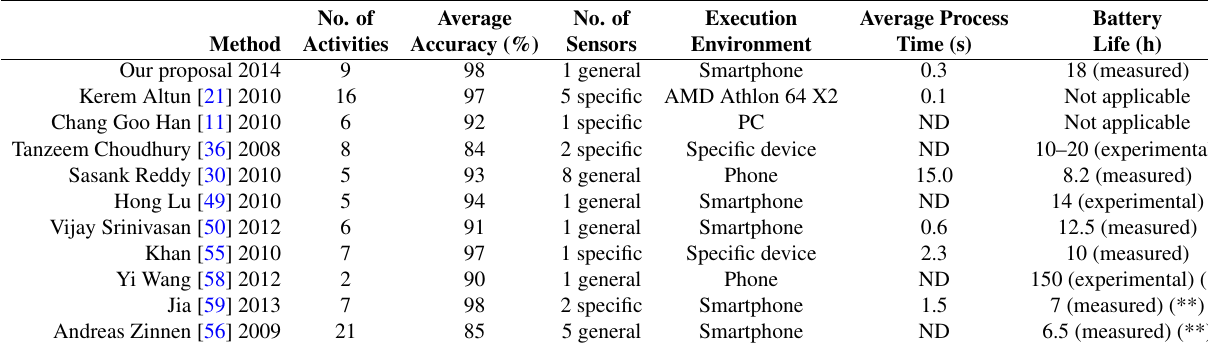
Table 9. Comparison with other activity recognition systems. ND (not determined). * These results are a little confusing. Most smartphones’ batteries rarely reach up to 120 h making intensive use of the accelerometer. Furthermore, only two activities (stable or moving) are recognized. ** Making intensive use of